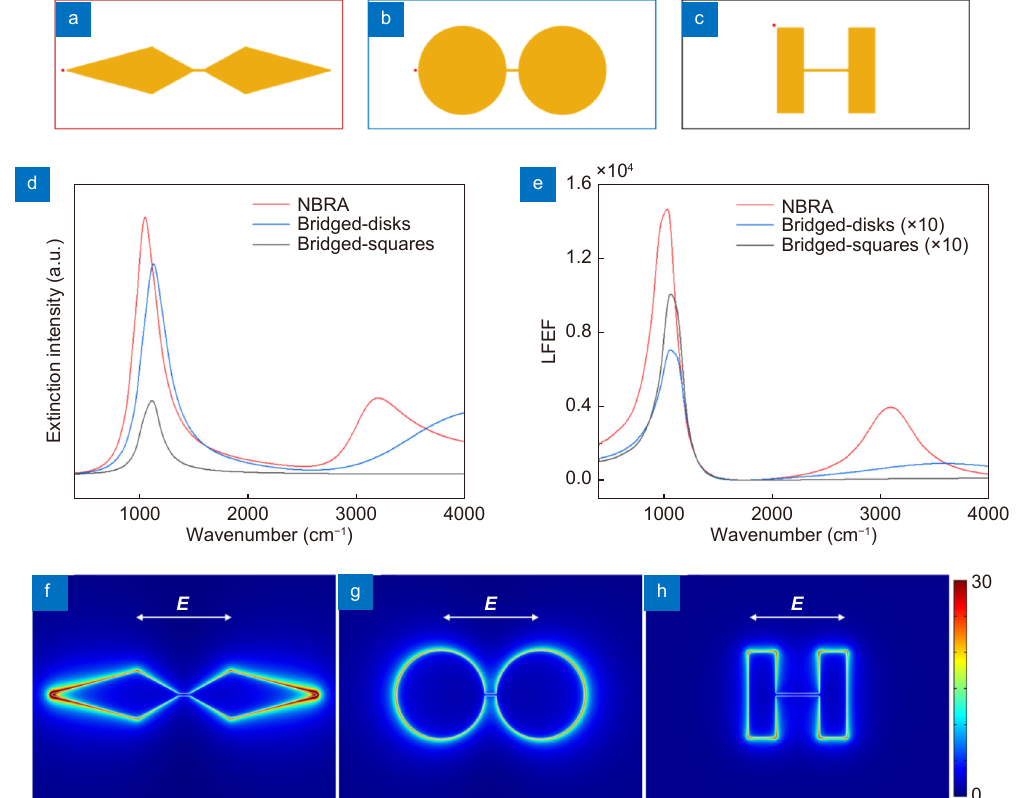
Fig. 2 | The model of ( a ) NBRA, ( b ) nano-bridged disks and ( c ) nano-bridged rectangles. All the structures are placed on the CaF 2 substrate. The incident polarizations are along the long-axis of the nanobridge. The thickness and the width of the nanobridge are 30 nm for all three structures. The lengths of the nanobridges are 130 nm for the NBRA and the nanobridged-disks, and 500 nm for the nanobridged-rectangles. The total length of the NBRA is 3000 nm. The radius of the disks are 500 nm. The length and width of the rectangles are 962 nm and 308 nm, respectively. The red points in (a–c) are the positions where the LFEFs are evaluated. The LFEF was evaluated at the point 2 nm away from the structure along the long axis and 15 nm above the CaF 2 substrate for the NBRA and the nanobridged-disks. While for the nanobridged-rectangles, the evaluating point is 2 nm away from the corner of the rectangle. ( d ) The simulated extinction spectra and ( e ) the LFEFs of all three structures. E- field distributions at the CTP resonance for ( f ) the NBRA, ( g ) the nanobridged-disks and ( h ) the